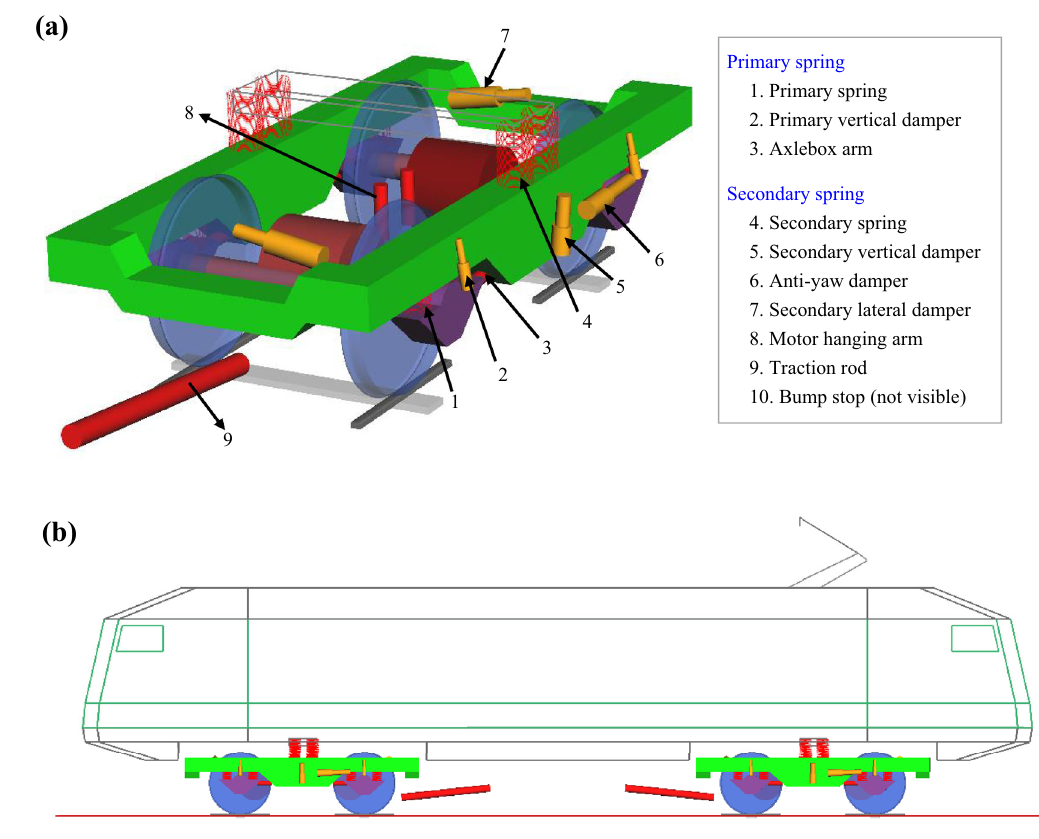
Fig. 8 Modeled elements of the suspension system ( a ) and the MBS model of the BOMBARDIER TRAXX locomotive ( b ) Table 1 Related information of the locomotive-railway line